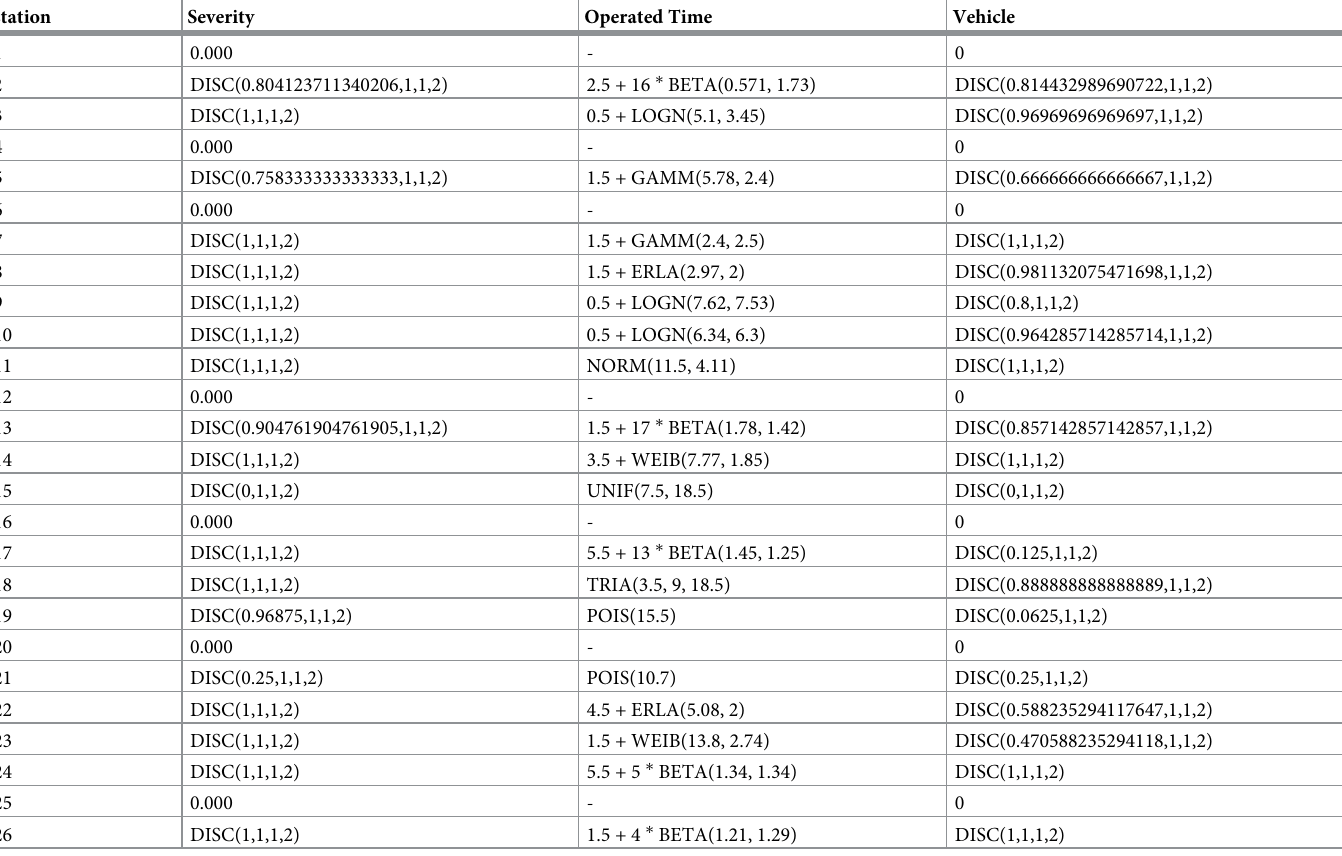
Table 4. Probability distributions of severity, operated time and